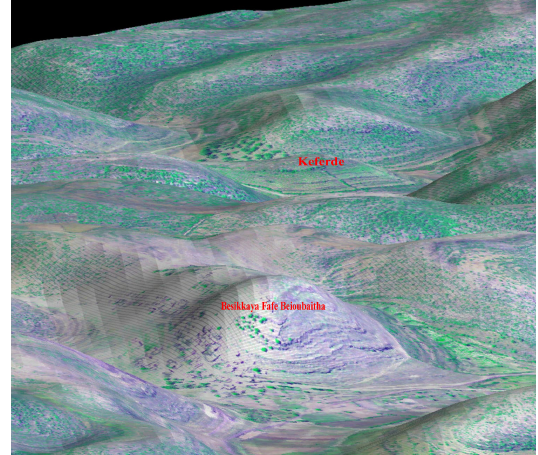
Fig. 3. A landscape model displaying the sites of Keferde (963 m a.s.l.) and Be ş ikkaya (995 m a.s.l.). View from north to south with Be ş ikkaya in the front. Created by Markus Törmä using ERDAS ER Mapper 2016.